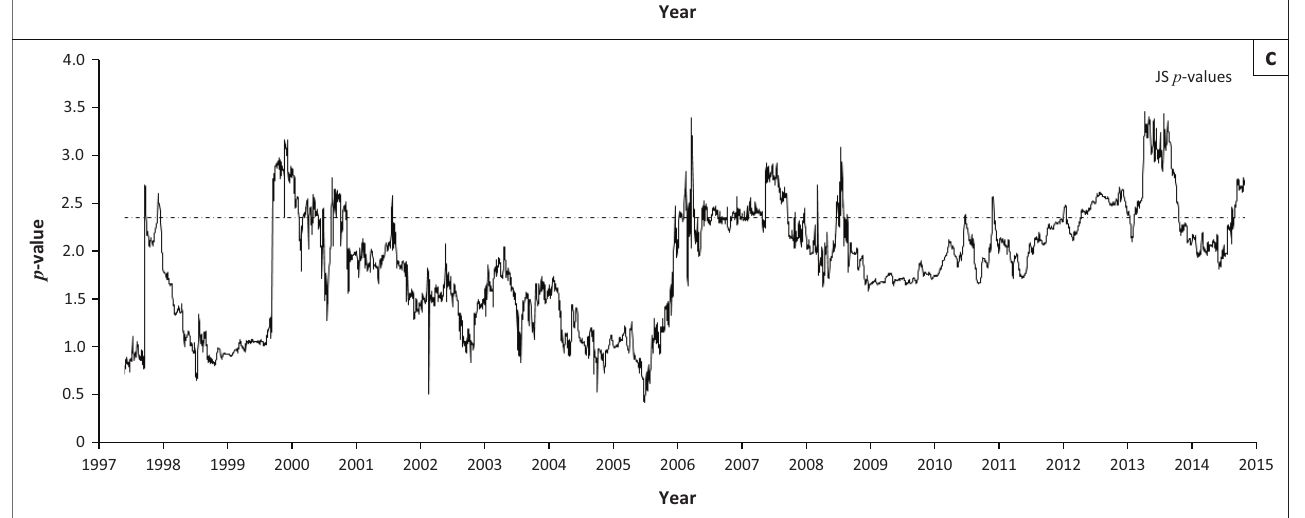
FIGURE 2: J200 – Top 40 index: (a) AVR p -values, (b) JM p -values, (c) JS p